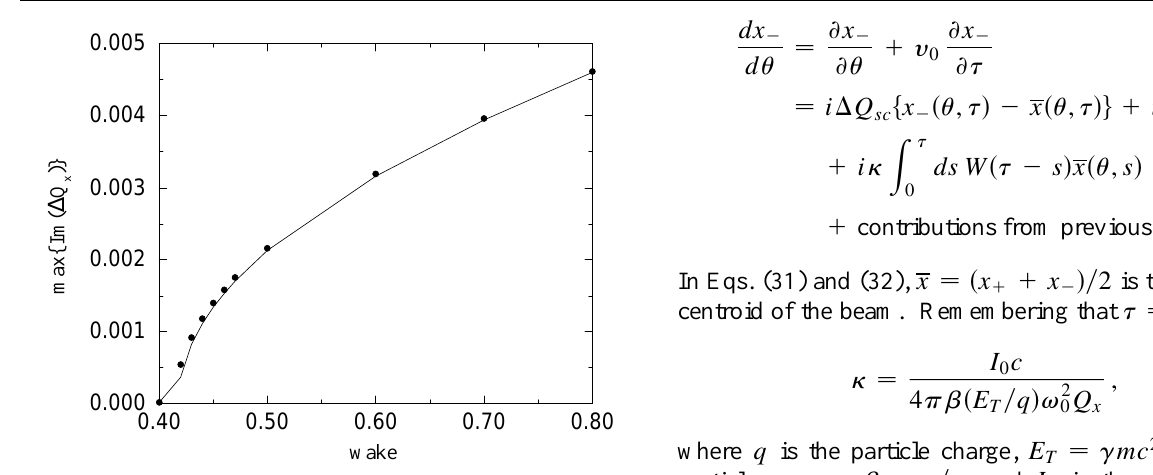
FIG. 10. Largest value of Im (cid:115) D (cid:81) (cid:120) (cid:100) versus wake strength from simulations with D (cid:81) (cid:115)(cid:99) (cid:173) (cid:48) , (cid:81) (cid:115) (cid:173) (cid:48)(cid:46)(cid:48)(cid:49) and different longitudinal forces: m (cid:173) 2 (cid:49) (cid:121) (cid:50) in a quadratic potential, circles; square well model, solid line. For wake , (cid:48)(cid:46)(cid:52) there was no instability. (cid:88) 2 (cid:115) u (cid:44) t (cid:100) in similar fashion for particles with (cid:100) t (cid:121) (cid:100) u (cid:173) 1y (cid:48) .